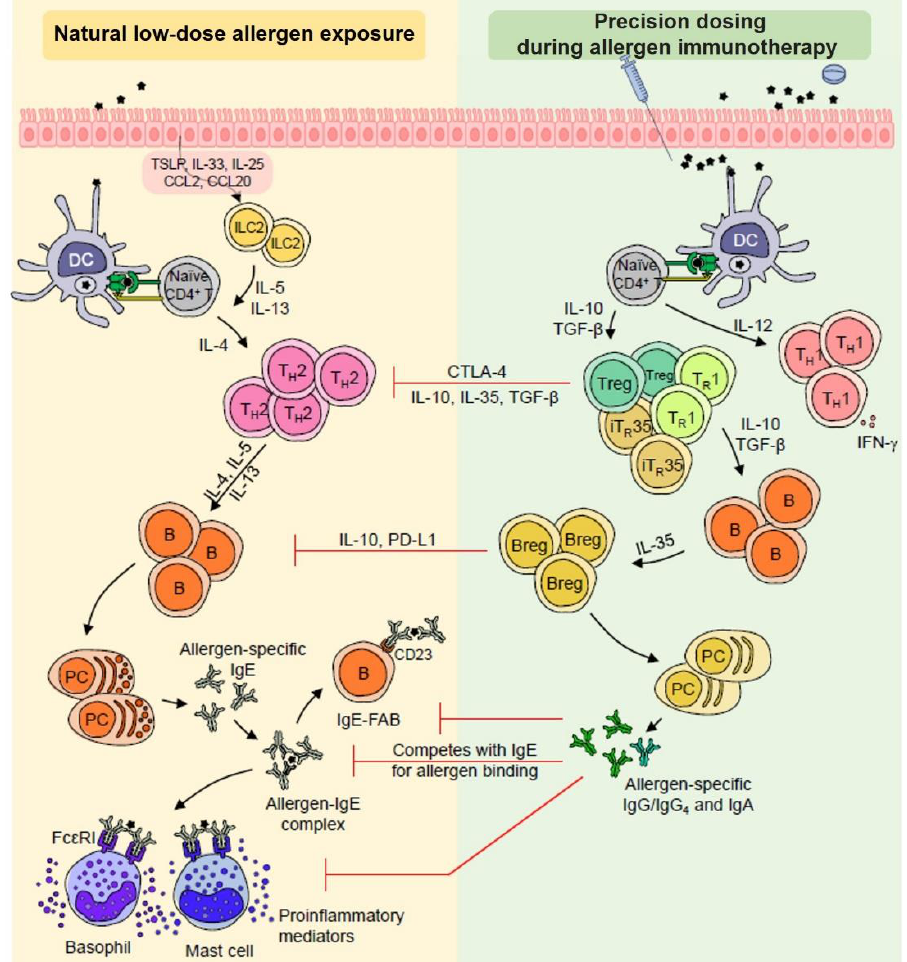
Figure 1. Mechanisms of allergic inflammation (in case of natural allergen exposure) and of immuno- logical and clinical tolerance (in case of precision dosing during AIT)—Figure adapted from [3] with permission from Elsevier. Stars represent a given allergen. Breg, Regulatory B cell; DC, Dendritic cell; CCL, Chemokine ligand; CD, Cluster of differentiation; CTLA-4, Cytotoxic T-lymphocyte-associated protein 4; Fc ε RI, Type I Fc ε receptor; IFN- γ , Interferon γ ; Ig, Immunoglobulin; IgE-FAB, IgE-facilitated allergen binding; IL, Interleukin, ILC2, Group 2 innate lymphoid cell; iT R 35, IL-35-producing Treg; PC, Plasma cell; PD- L1, Programmed death-ligand 1; TGF- β, Transforming growth factor β; T H , T helper; T R 1, Type 1 Treg; Treg, Regulatory T cell; TSLP, Thymic stromal lymphopoietin.